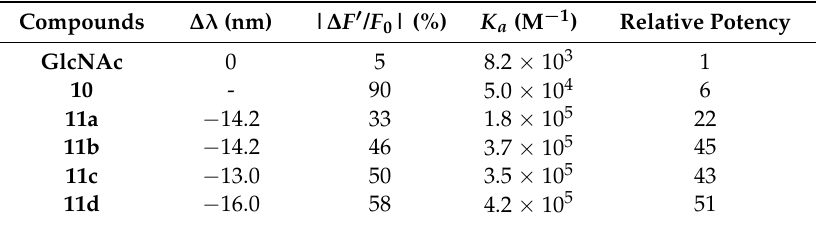
Table 3. Results of the binding assays for WGA on the basis of fluorescence measurements. Compounds ∆ λ (nm) | ∆ F (cid:48) / F 0 | (%) K a (M − 1 ) Relative Potency GlcNAc 0 5 - 90